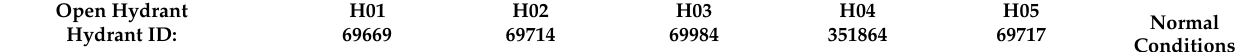
Figure 14. Contour map of pressure drop areas caused by open hydrants in the DMA 02 zone. Table 3. Measurement indications of the monitoring system (existing and additional) in the analysed DMA